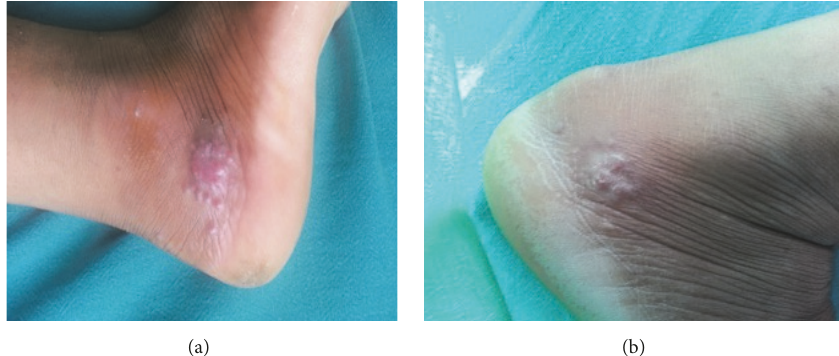
Figure 2: (a) Multiple erythematous papules of lupus vulgaris below lateral malleolus of right foot of 34-year-old female with a history of trauma on the right foot working in field 6 months earlier (before treatment). (b) The erythematous plaque reduced but did not resolve completely after antitubercular therapy; antitubercular therapy continued for three more